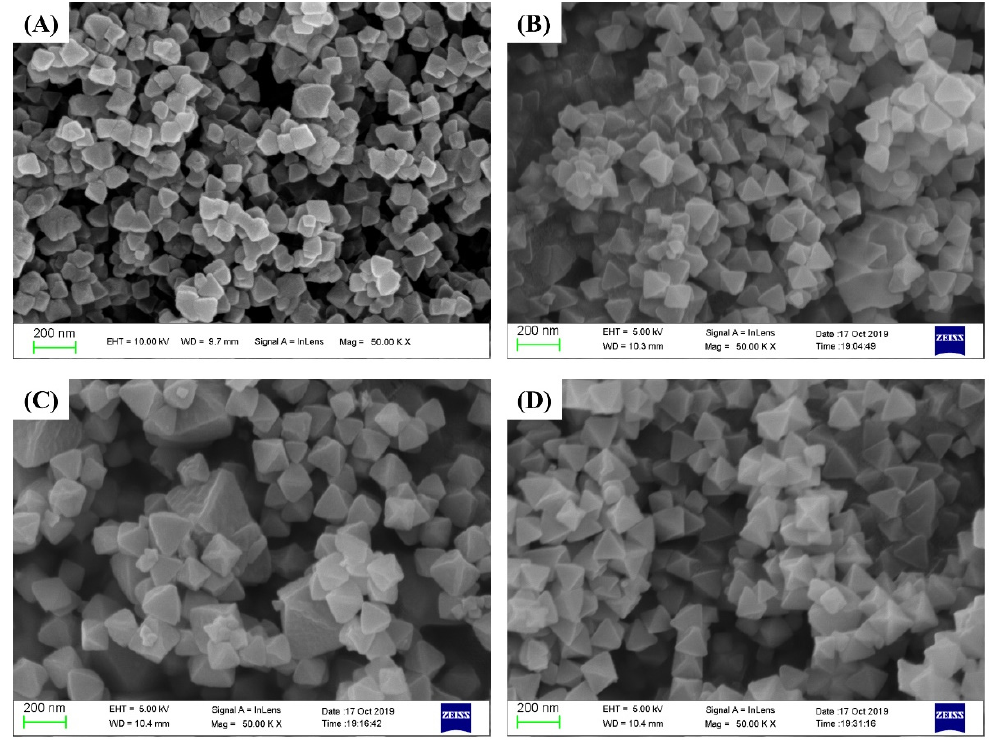
Figure 3. Scanning electron microscopy (SEM) images of the obtained MOF products. ( A ) MOF 0 , ( B ) MOF 1, ( C ) MOF 3, and ( D ) MOF 5 .